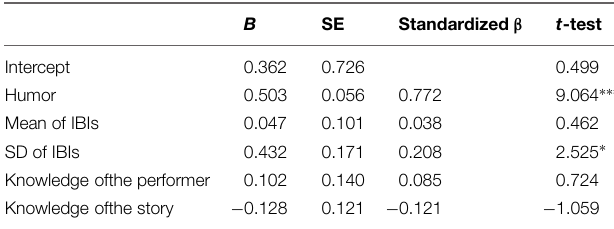
TABLE 3 | Regression analysis of humor ratings, IBI statistical values, and domain knowledge of experience of transportation. B